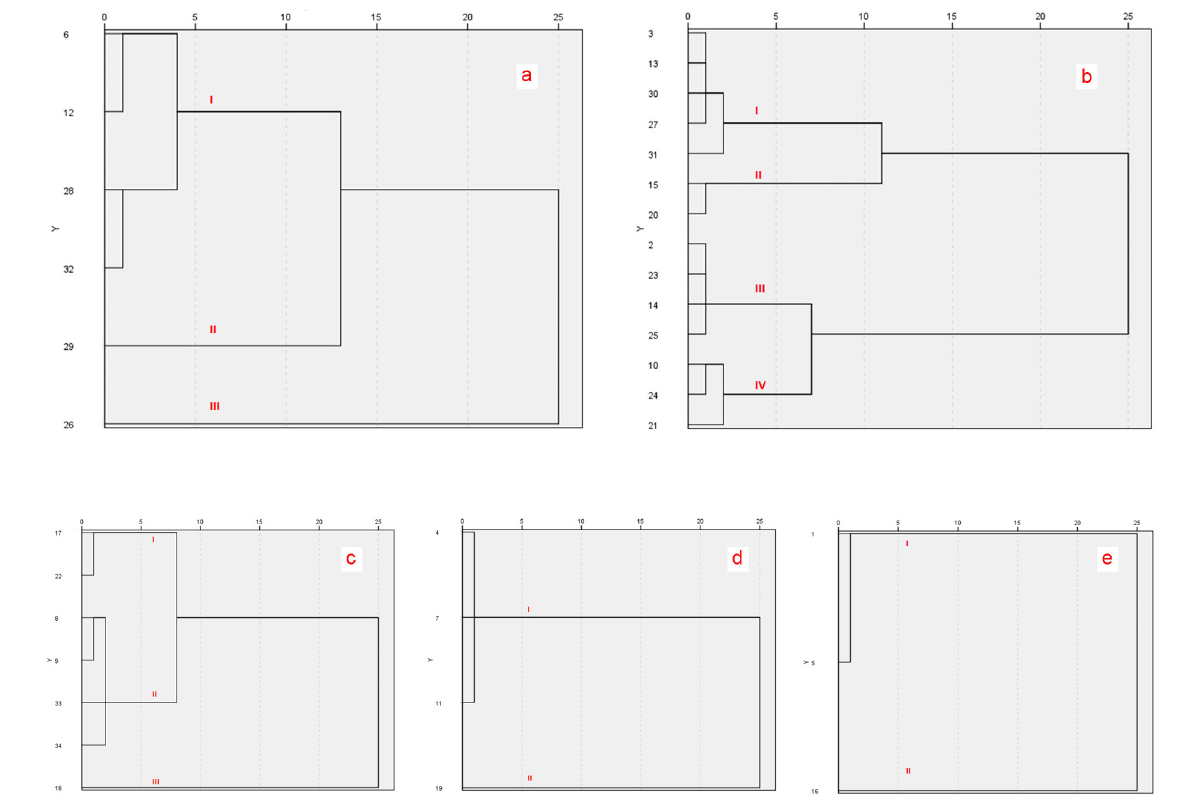
Fig. 1: Dendograms that group the variables studied according to harvesting time. Dendograms using Average Linkage (between groups) - Rescaled Distance Cluster Combine. a) Very Early b) Early c) Medium d) Late e) very